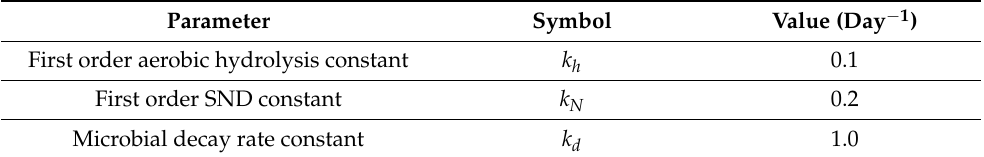
Table 2. Biological parameters for